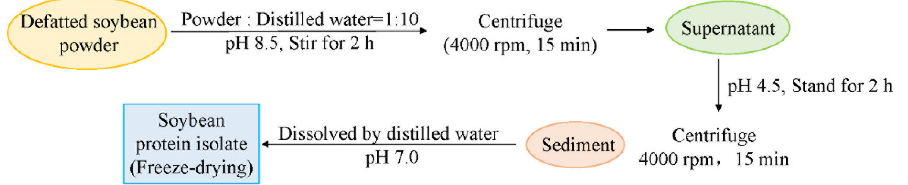
Figure 6. Specific extraction process for SPI.